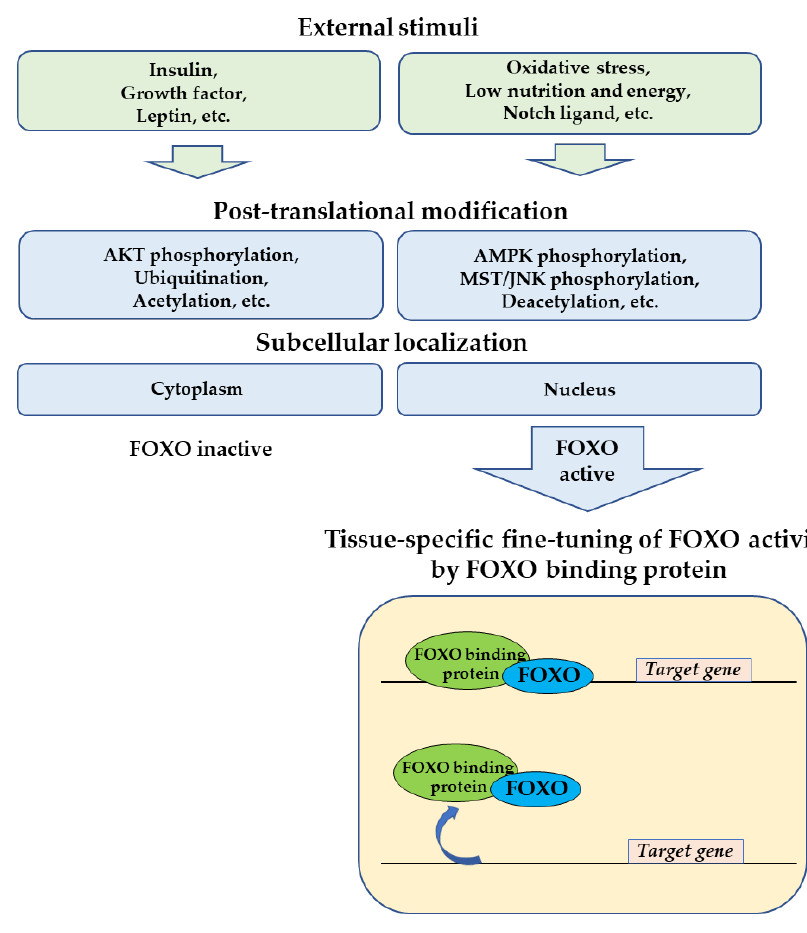
Figure 12. Multilayer regulation and fine-tuning of FOXO activity. In response to various external stimuli, post-translational modification of FOXO determines the subcellular localization and activity of FOXO. Tissue-specific transcription of the target genes by FOXO is fine-tuned by FOXO-binding